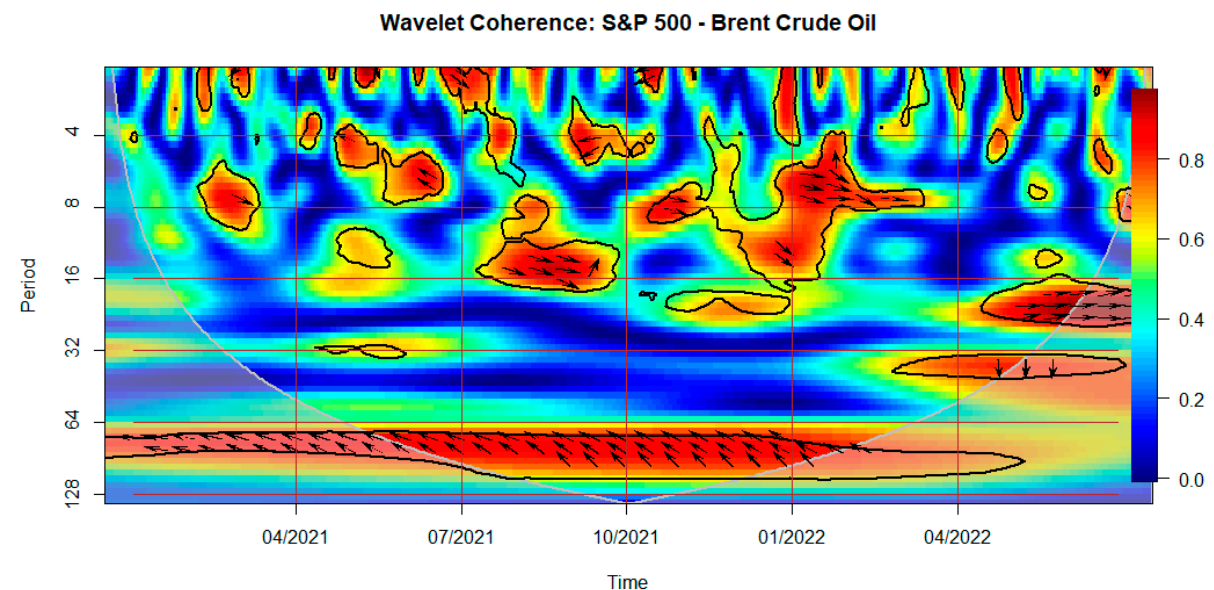
Figure 3. Wavelet coherence between S&P 500 and Brent crude oil.